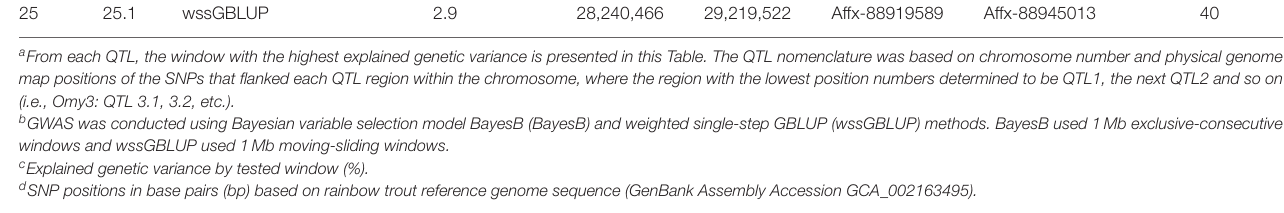
TABLE 3 | Summary of QTL associated with BCWD survival STATUS in NCCCWA population detected using the 57K SNP array. Omy QTL a GWAS method b Genetic variance (%) c Physical Map (bp) d Markers in Window SNPs per window Start End Start-SNP